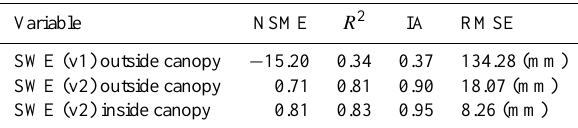
Table 3. Performance of ESCIMO.spread v1 and ESCIMO.spread v2 at site Vordersteinwald for the winter period 2012/2013. As ES- CIMO.spread v1 does not include formulations of inside-canopy processes, model performance for inside-canopy conditions is only available for ESCIMO.spread v2. The simulations inside the canopy are based on modified outside-canopy meteorological